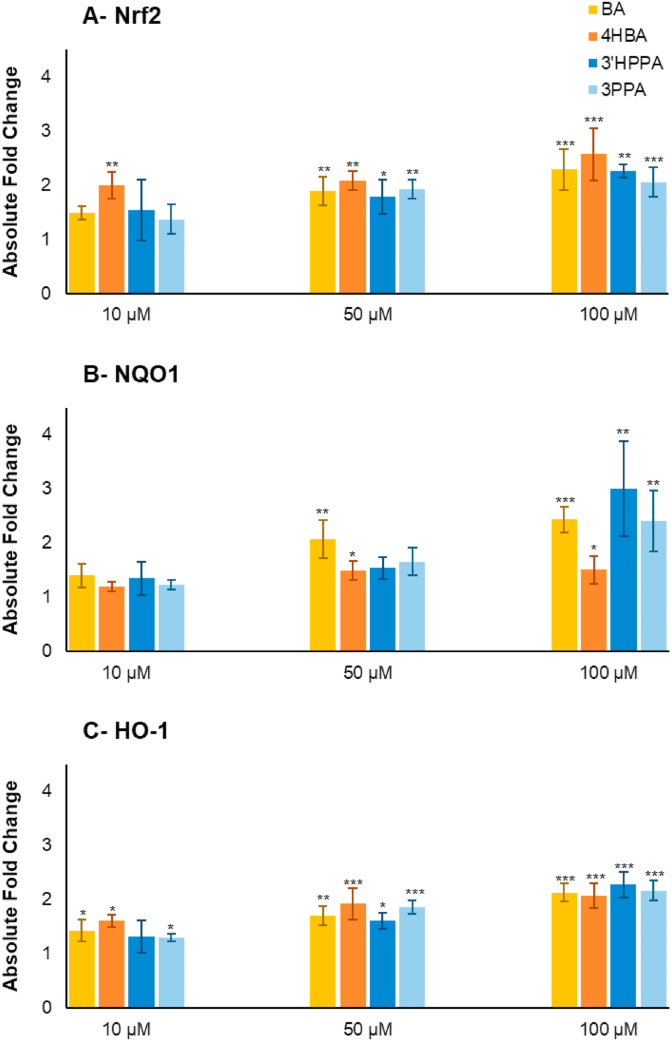
Change in (A) Nrf2, (B) NQO1, (C) HO-1 gene expression after pre-incubation with four phenolic compounds. Benzoic acid (BA), 4-hydroxybenzoic acid (4HBA), 3-(3′-hydroxyphenyl)propanoic acid (3′HPPA), and 3-(phenyl)propanoic acid (3PPA). Absolute fold change in expression is presented as mean of 3 independent experiments ±SDM on CCD 841 CoN cells. Significance is compared to normalised untreated control using One-way ANOVA and Dunnett's Multiple Comparisons test. *p < 0.05, **p < 0.01, ***p < 0.001.